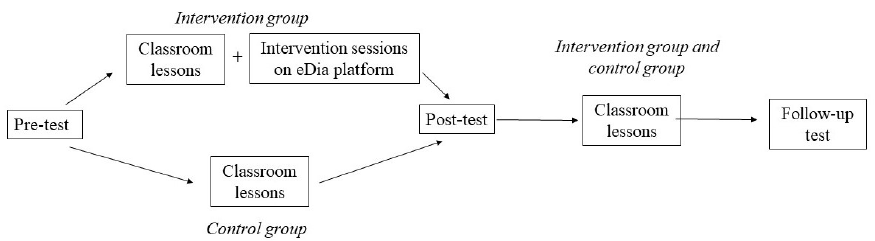
Figure 5. Educational processes in the intervention group and in the control group.